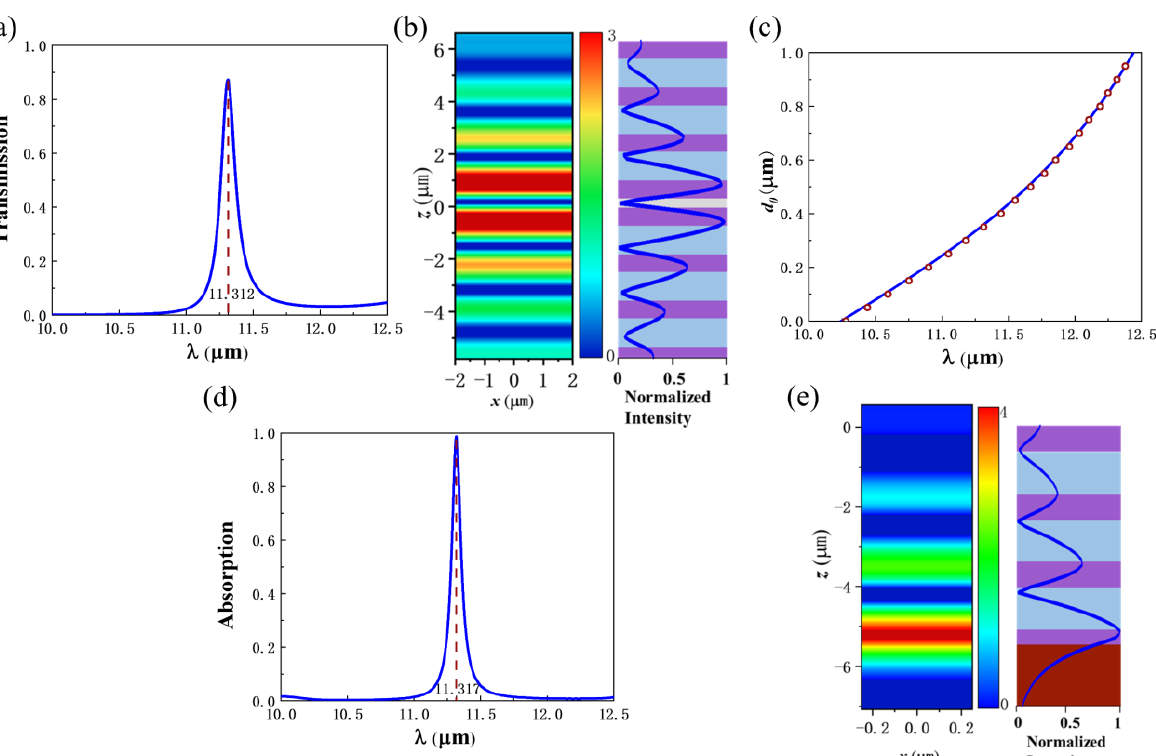
Figure 2. ( a ) The transmission spectrum of the OTS mode produced by the PhC heterostructure. (N 1 = 3, N 2 = 3, and d 0 = 0.35 µ m). ( b ) The electric field intensity distribution of OTS at 11.312 µ m. ( c ) The relationship between the resonance wavelength of the OTS and the air layer thickness (N 1 = 3, N 2 = 3). ( d ) The absorption spectrum of the PhC2-SiC structure. (N 2 = 3) ( e ) The electric field intensity distribution of TPhP at 11.317 µ m (N 2 = 3).